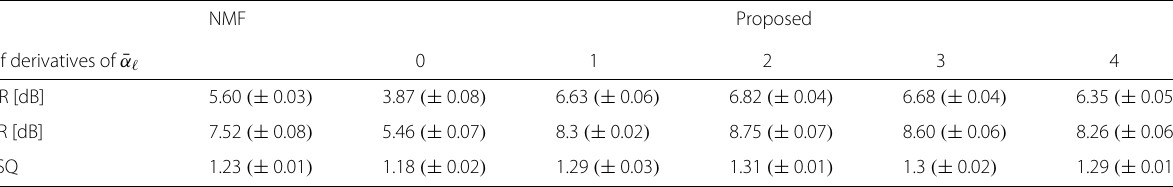
Table 6 Performance for different designs of ¯ α (cid:2) : if no derivatives are considered, ¯ α (cid:2) is composed of angular positions only. If one derivative is considered, ¯ α (cid:2) contains angular positions and their first order temporal derivatives. For this experiment, ego-noise caused by movements of Sequence II is used, SNR=0 dB, K = 30, K S = 20, (cid:5) = 5 · 10 − 3 , λ T = 0.9, and λ E = 2 NMF